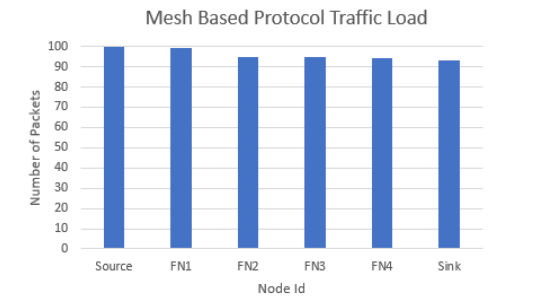
Figure 15. Traffic load mesh (flooding)-based